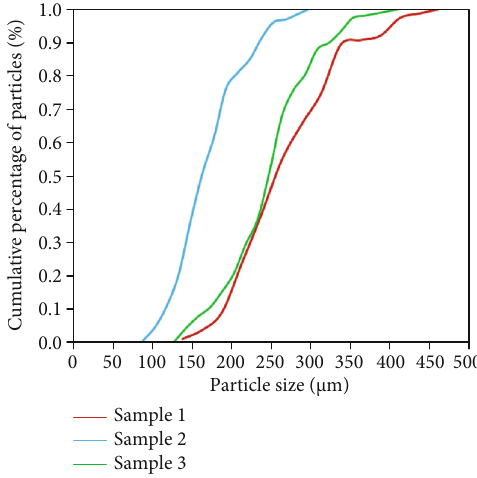
Figure 6: Cumulative distribution curves of the mineral particles in the oil sand